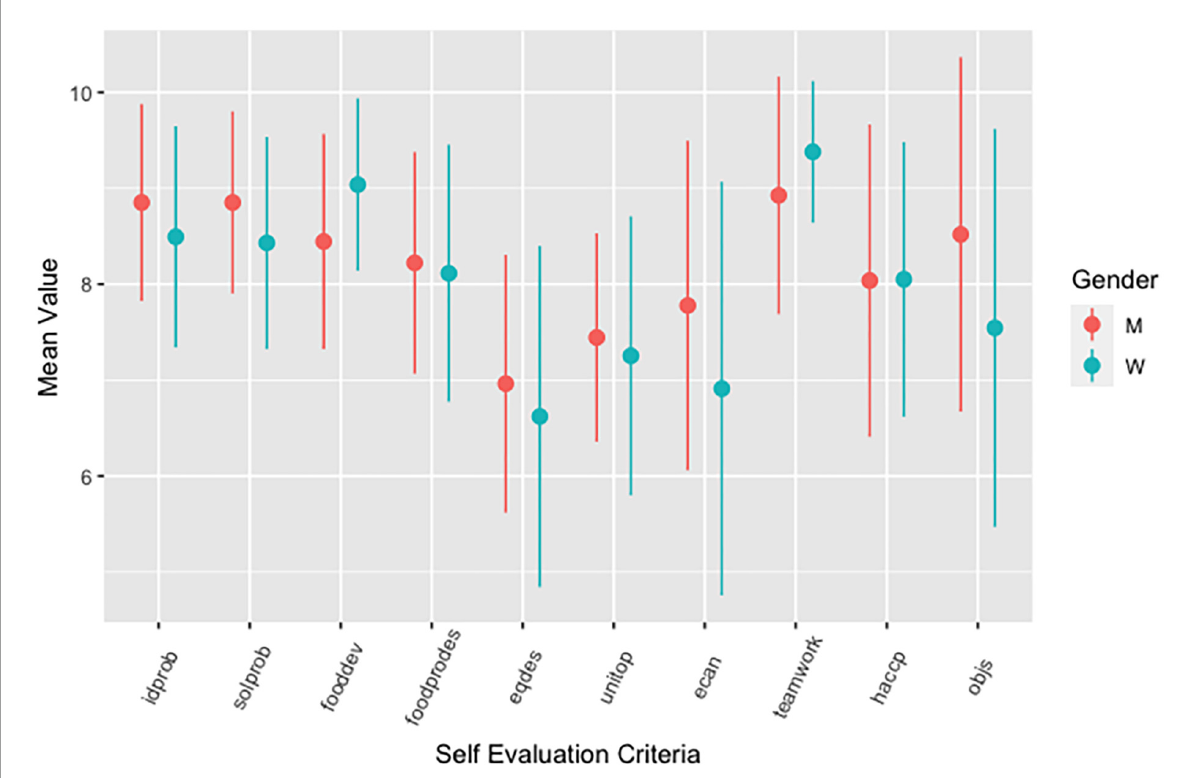
FIGURE3 Self-evaluation means values for all students classified by gender and category or criteria with standard deviation. The self-assessment used 10 as the highest grade and 1 as the lowest (M, Men; W,